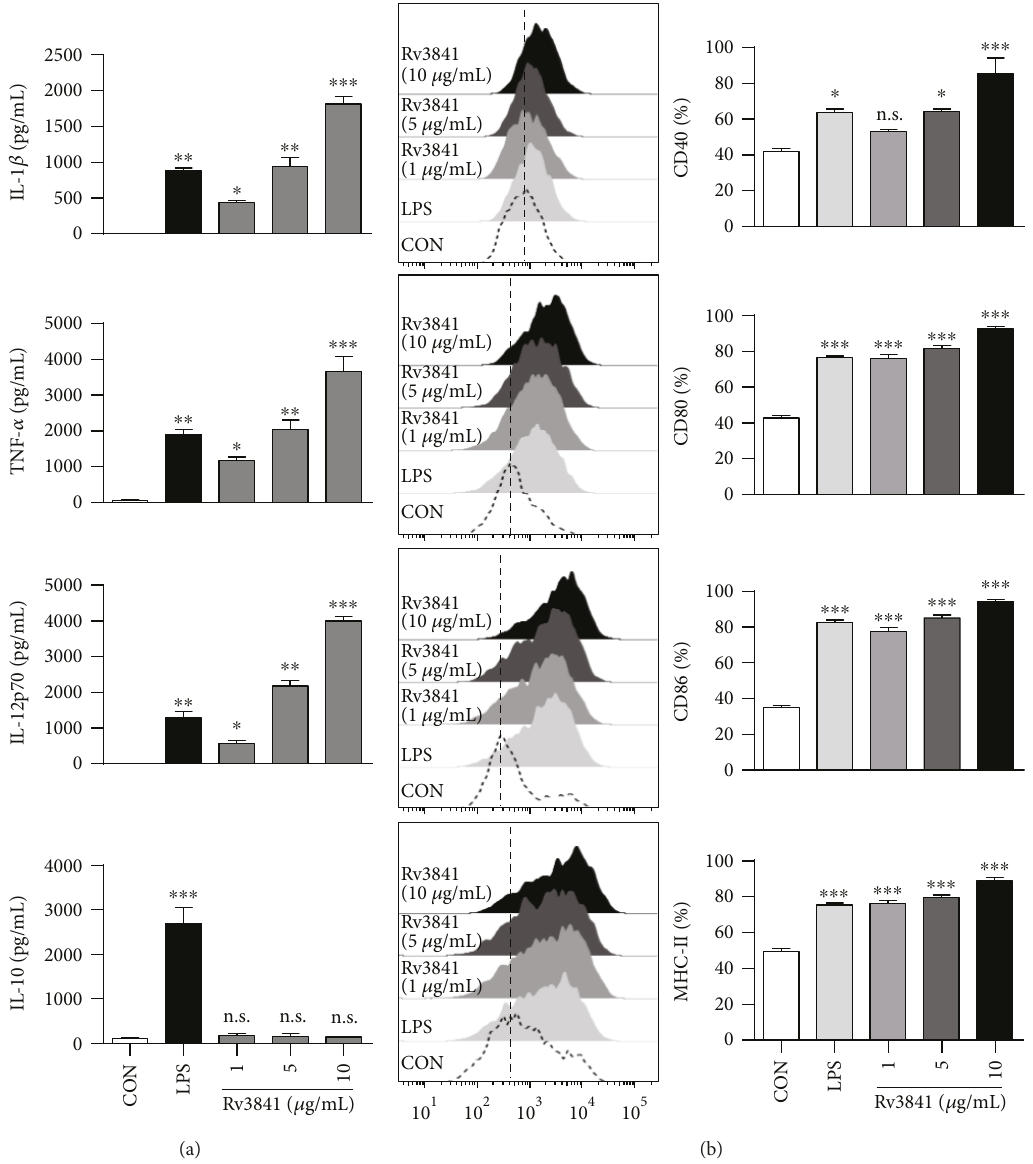
Figure 1: Rv3841 induces DC maturation. (a) Rv3841 induced functional activation of DCs in a dose-dependent manner. Immature DCs (10 6 cells/mL) were cultured in the presence of 1, 5, or 10 μ g/mL Rv3841 or 100 ng/mL LPS for 24h. The quantities of TNF- α , IL-1 β , IL-10, and IL- 12p70 in the culture supernatant were determined by ELISAs. All the data were expressed as mean ± SD ( n = 3 ). The levels of signi fi cance ( ∗ p < 0 05 , ∗∗ p < 0 01 , or ∗∗∗ p < 0 001 determined by one-way ANOVA) of the di ff erences between the treatment data and the control data are indicated; treatments that were not signi fi cantly di ff erent are indicated by “ n . s . ” (b) Rv3841 induced phenotypic and functional activation of DCs in a dose-dependent manner, and the cells were analyzed for the expression of surface markers by fl ow cytometry. The cells were gated on CD11c + . The DCs were stained with an anti-CD80, anti-CD86, anti-MHC class I, or anti-MHC class II antibody. The percentage of positive cells is shown in each panel. The bar graphs depict data as mean ± SD ( n = 3 ). The levels of signi fi cance ( ∗ p < 0 05 or ∗∗∗ p < 0 001 , determined by one-way ANOVA) of the di ff erences between the treatment data and the control data are indicated. Treatments without a signi fi cant e ff ect are indicated by “ n.s.